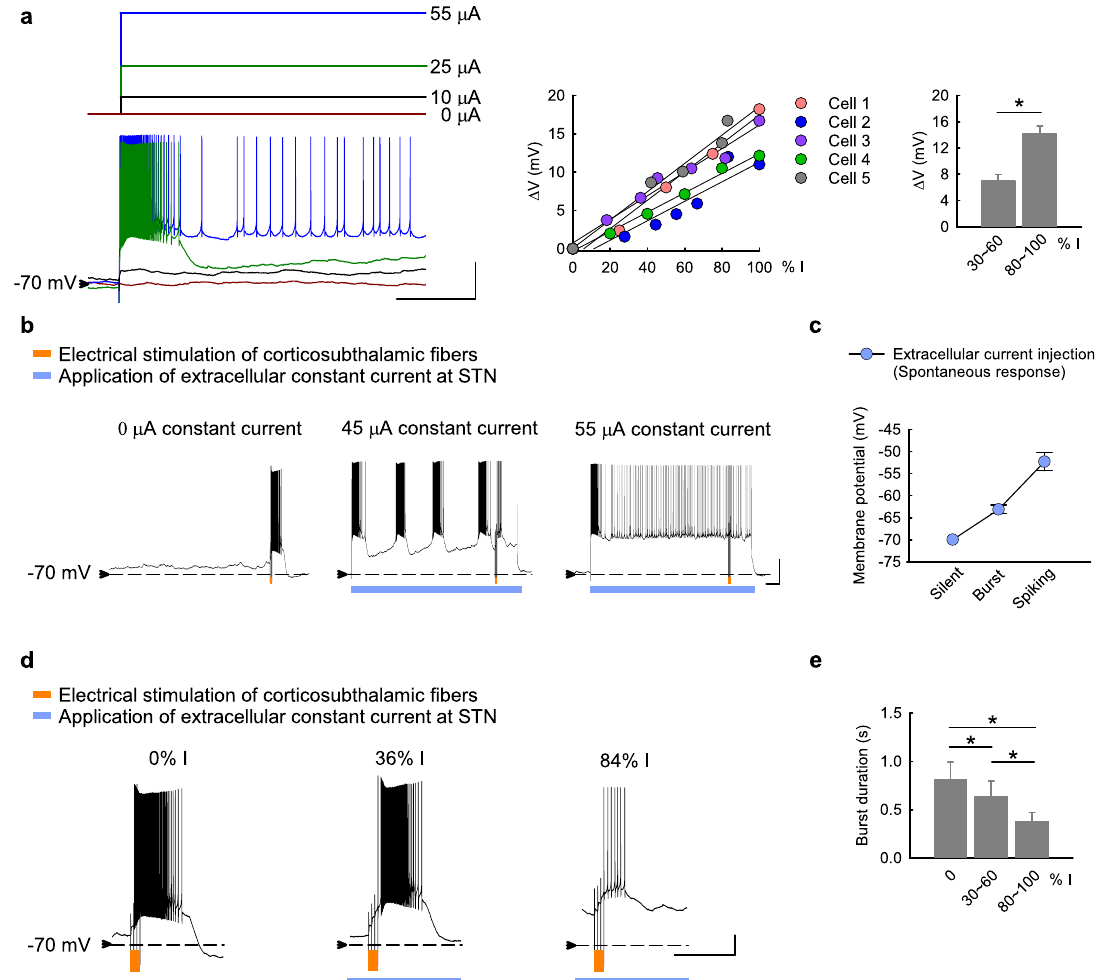
Fig. 9 Modulation of membrane potential and discharge patterns of STN neurons by extracellularly applied constant currents. a The baseline membrane potential of STN neurons is changed correlative to the amplitude of extracellularly applied negative currents in acute brain slices from parkinsonian rats (left panel, n = 5). The percentage (% I) of the smallest current amplitude that switches the neuron into the spike mode of fi ring for each neuron is shown. There is tight correlation between the applied current amplitude and the change in membrane potential ( Δ V , middle and right panels). b Electrical stimulation of cortico-subthalamic fi bers (orange marks, 4 pulses at 20 Hz) elicits subthalamic neuronal discharges, which are further modulated by the extracellular constant currents (blue bars). The 4-pulse stimulation elicits a burst of discharges outlasting the stimulation period in a STN neuron with a baseline membrane potential of ~ − 70 mV and without spontaneous activities (left panel). Application of an extracellular negative current of 45 μ A modestly depolarizes the baseline membrane potential, at which spontaneous quasi-rhythmic burst discharges develop and the 4-pulse stimulation on cortical fi bers elicits a shorter burst outlasting the stimulation period (middle panel). When a stronger extracellular negative current of 55 μ A is given, the baseline membrane potential is even more depolarized and spontaneous spike discharges prevail. Here the same 4-pulse stimulation elicits no burst discharges but increases the spike frequency (only during but not outlasting the stimulation period, right panel). c The discharge pattern (electrical silence, spontaneously repetitive bursts, or spike-mode discharges) is closely correlated with the baseline membrane potential adjusted by extracellular constant currents ( n = 4). d The duration of the burst discharges elicited by cortical fi ber stimulation is the longest when no depolarizing extracellular currents are given ( “ 0% I ” ), and gets shorter when stronger extracellular currents are given (e.g. “ 36 % I ” vs. “ 84 % I ” ). e Cumulative results in ( d ) demonstrate a clear tendency of shorter burst duration with more depolarized baseline membrane potential upon extracellular current injection ( n = 5 – 6). Scale bars represent 1 s/20 mV. Data with two groups were analyzed with Mann – Whitney U tests, and data with three groups were analyzed with Friedman tests (followed by the Wilcoxon signed-rank tests for further pairwise comparison). * P <